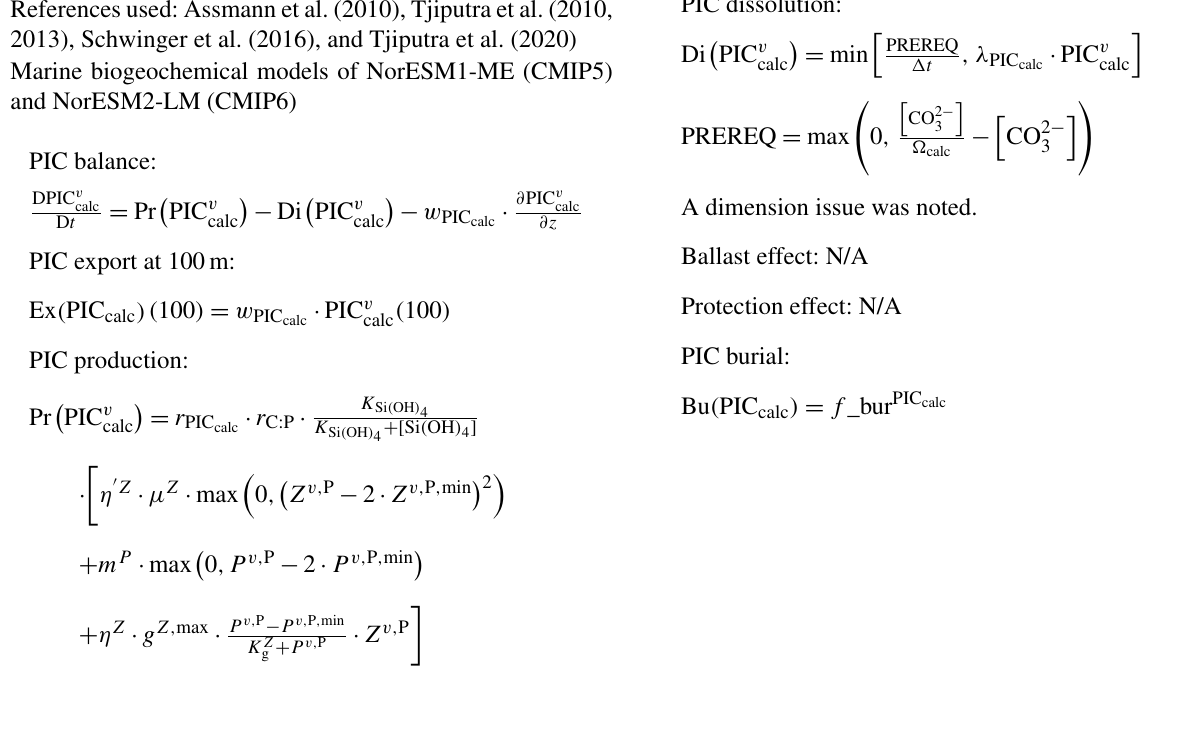
Table C16. HAMOCC5.1 and iHAMOCC parameters. Variable/parameter Value Unit Description (cid:16) (cid:17) f _bur PIC calc f PIC bottom calc , (cid:127) calc , sediment dynamics molCm − 2 d − 1 Function defining the PIC calc